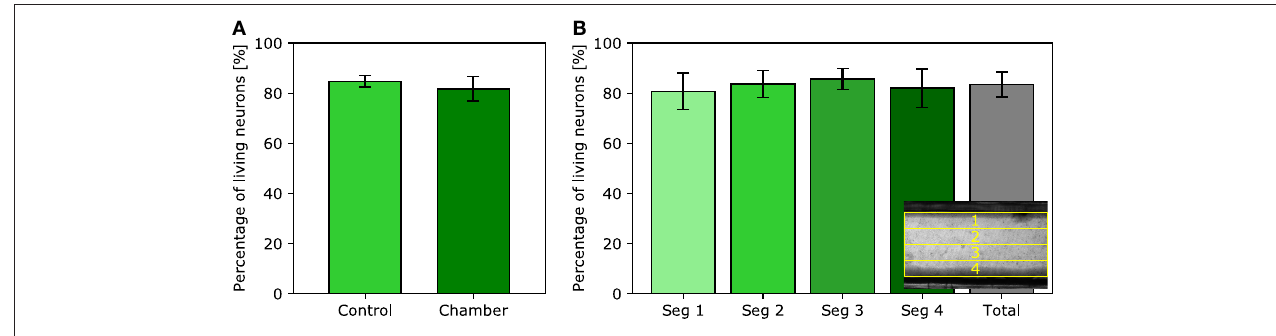
FIGURE 4 | Neurons viability assay. (A) Average percentage of living neurons observed in the control experiment and in the imaging slit of the flow chamber. (B) Average percentage of living neurons in each segment of the imaging slit. Inset: top-view visualization of the separation of the four segments; lines one and four are positioned near the edges of the imaging slit.